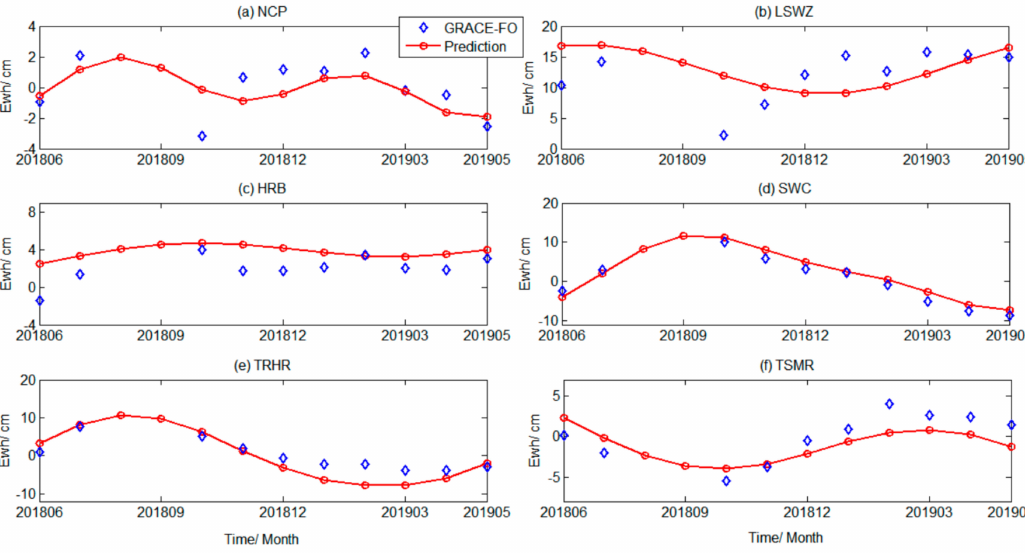
Figure 9. Comparison of predicted GRACE TWS changes with GRACE-FO results. The blue scatters represent the GRACE-FO results and the red curve expresses the change of TWS predicted within the 10